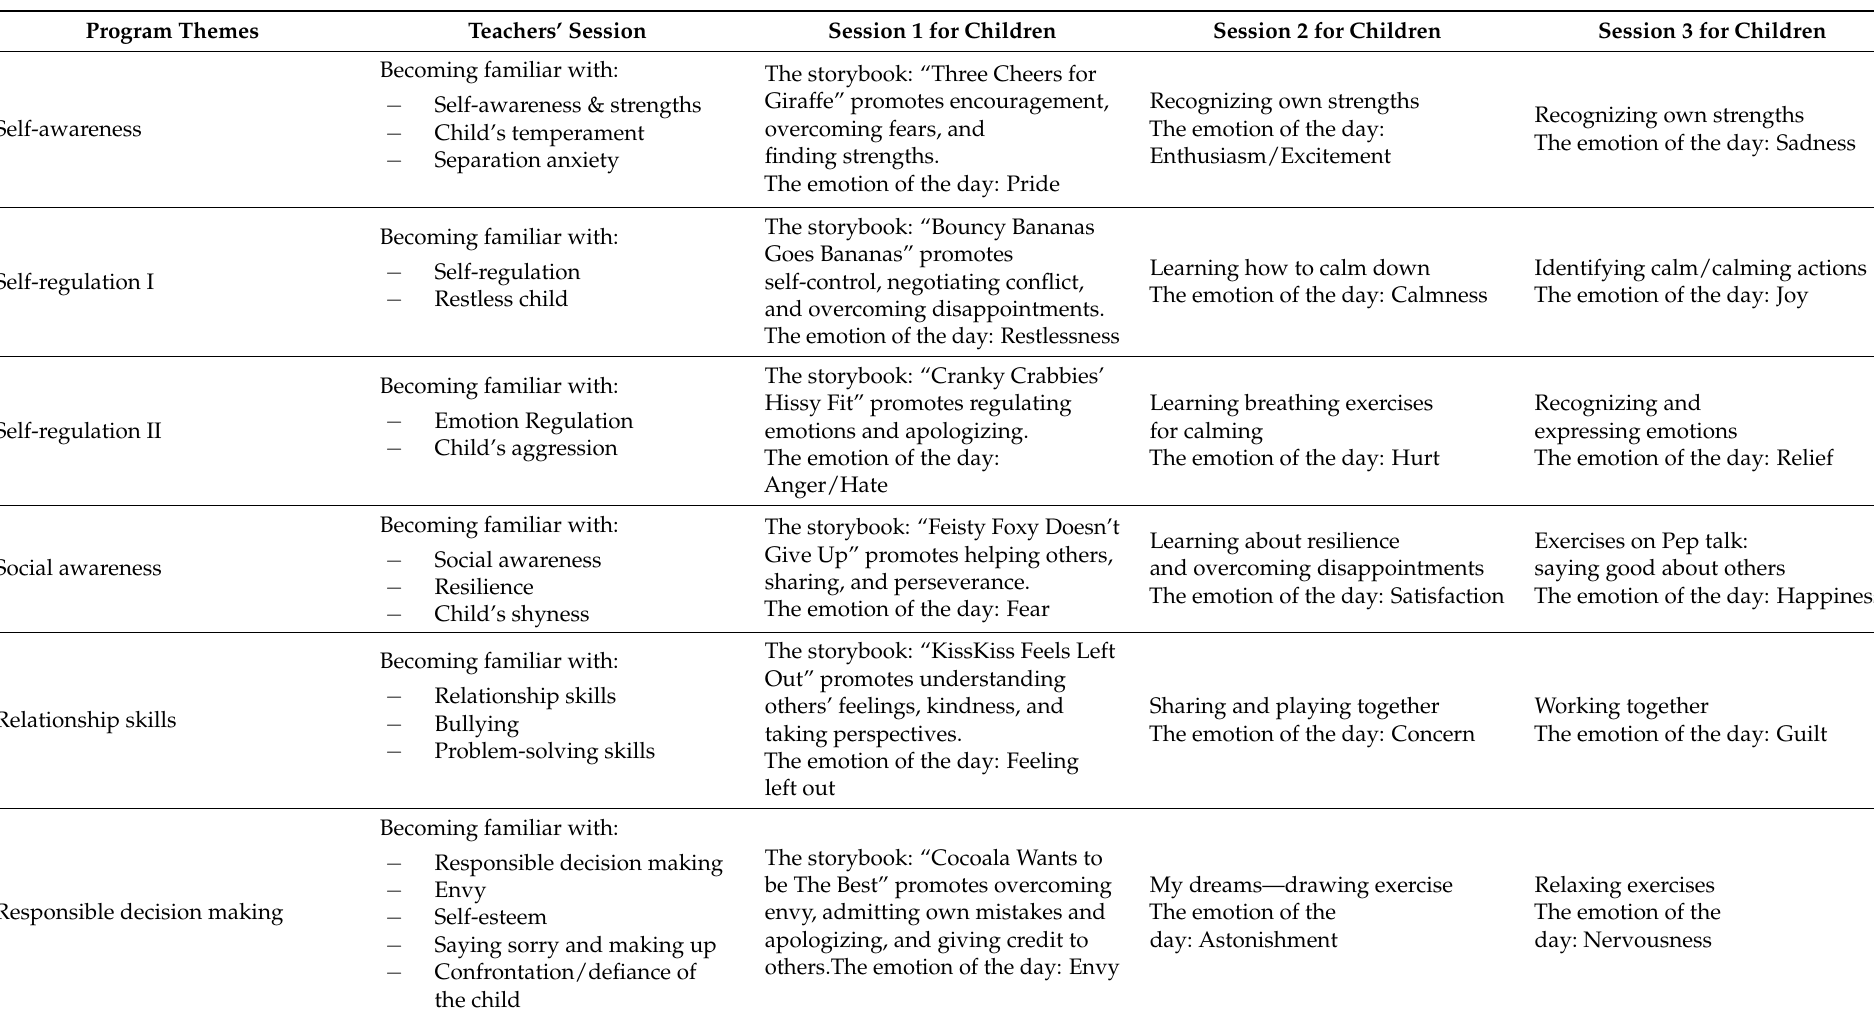
Table 2. The Roundies curriculum themes and description of teachers’ and children’s